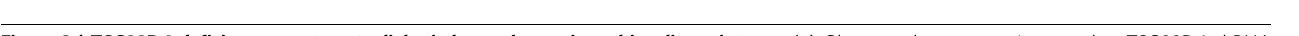
Figure 3 | TSC22D4 deficiency counteracts diabetic hyperglycaemia and insulin resistance. ( a ) Glucose tolerance test in control or TSC22D4 shRNA adenovirus–injected db/db mice 1 week after injection. Glucose was injected i.p. at a concentration of 1g glucose kg (cid:2) 1 body weight (means ± s.e.m., n Z 6). ( b ) Serum glucose levels in same mice as in a after 16h fasting and refeeding. ( c ) Serum insulin levels in same mice as in a . ( d ) Serum C-Peptide levels in same mice as in a after 16h fasting and refeeding. ( e ) Representative western blot of liver extracts from control (NC shRNA) or TSC22D4 (TSC shRNA) shRNA adenovirus–injected db/db mice; same mice as in a using indicated antibodies. Blot representative of 6 similar samples. ( f ) Glucose tolerance test in control or TSC22D4 shRNA adenovirus–injected NZO mice 1 week after injection. Glucose was i.p. injected at a concentration of 1g glucose kg (cid:2) 1 body weight (means ± s.e.m., n Z 6). ( g ) Serum glucose levels in same mice as in f after 16 h fasting and refeeding. ( h ) HOMA-IR index in control or